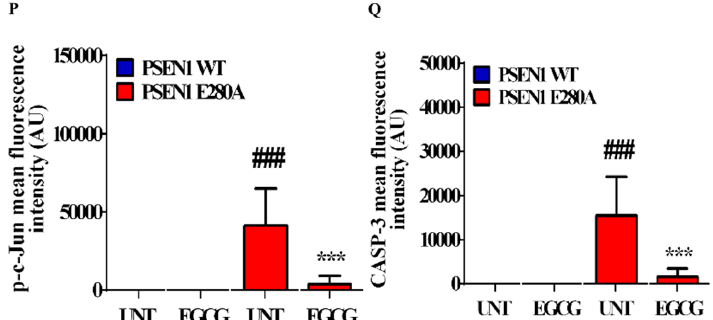
Figure 3. EGCG reduced the activation of P53, PUMA, c-JUN, and CASPASE-3 in PSEN1 E280A ChLNs. After 7 days of transdifferentiation, WT PSEN1 and PSEN1 E280A ChLNs were left untreated or treated with EGCG in a regular culture medium for 4 days. Then, cells were labeled with primary antibodies against c-JUN/total c-JUN, P53, PUMA, CASPASE-3 (CASP-3), and fluorescent secondary antibodies. The fluorescent contour plot shown in ( A ) were quantified ( B – E ). Additionally, cells were double-stained as indicated in the figure ( F – O ) with primary antibodies against P53 (green; F” – I” ), PUMA (red; F’ – I’ ), c-JUN (green; L” – O” ), and CASP-3 (red; N’ – O’ ). The nuclei were stained with Hoechst 33,342 (blue; F’’’ – O’’’ ). ( J , K , P , Q ) Quantification of P53 ( J ), PUMA ( K ), c-JUN ( P ), and CASP-3 ( Q ) fluorescence intensity. Data are expressed as the mean ± SD; #, * p < 0.05; ##, ** p < 0.01; ###, *** p < 0.001; ### represents differences compared to UNT PSEN1 WT cells; ** , *** represents differences compared to UNT PSEN1 E280A cells. The figures represent 1 out of 3 independent experiments. Image magnification, 200 ×